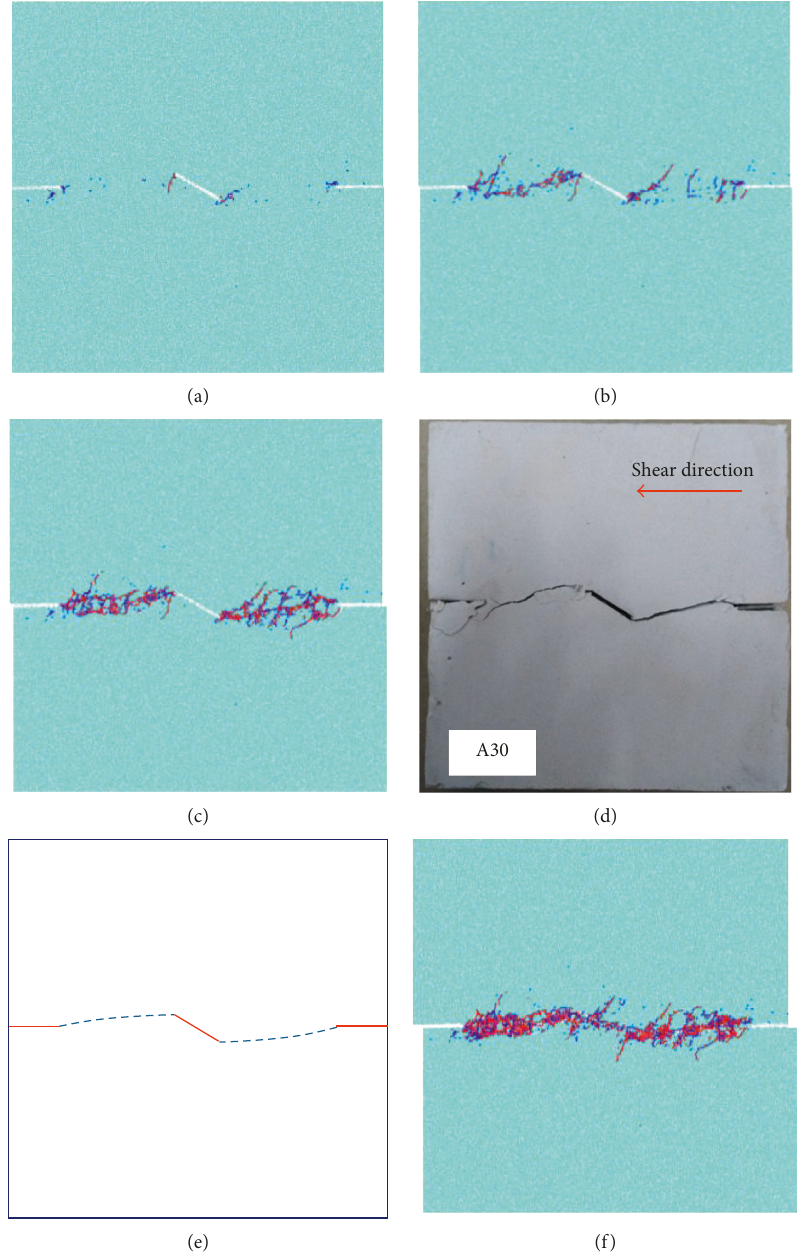
Figure 10: Fracturing process of Sample A30. (a) Point A. (b) Point B. (c) Point C. (d) Real failure. (e) Single sawtooth. (f) Point